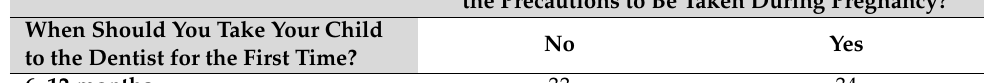
Table 6. Distribution according to information received by dental professionals about the first dental visit. Did You Ask for Advice or Have You Been Given Information by the Dentist, the Dental Hygienist on Variables the Precautions to Be Taken During